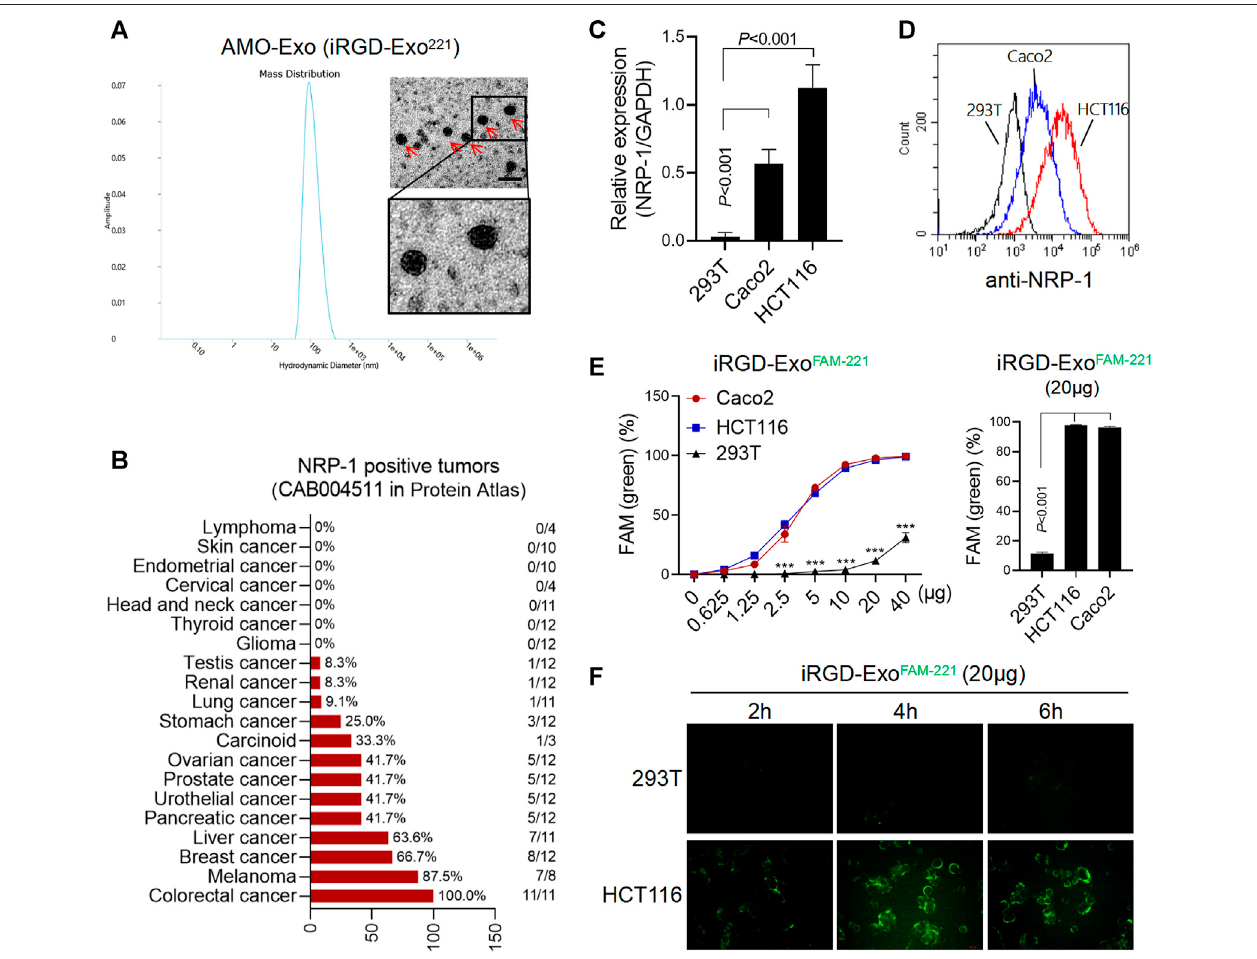
FIGURE2| AMO-loadedexosomesweretakenupbycoloncancercellsthrough NRP-1. (A) Electron microscopeanalysisand particlesizeanalysisofexosomes, scalebars (cid:2) 200 μ m. (B) TissueexpressionofNRP-1inaonlinedatabase(TheHumanProteinAtlas).Amajorityofcancertissuesshowedweaktomoderatecytoplasmic immunoreactivity with a granular pattern, and the expression of NRP-1 was highest in colon cancer. (C) Q-PCR was used to detect the relative expression of NRP-1 in colon cancer cells (HCT116 and Caco2) and 293T cells. (D) The surface expression of NRP-1 in colon cancer cells was detected by fl ow cytometry. (E) After co- incubation with the FAM-labeled exosomes, the positive rate of cells expressing FAM green fl uorescence was detected by fl ow cytometry. *** p < 0.001. (F) The green fl uorescence signal of cells was observed by fl uorescence microscopy.